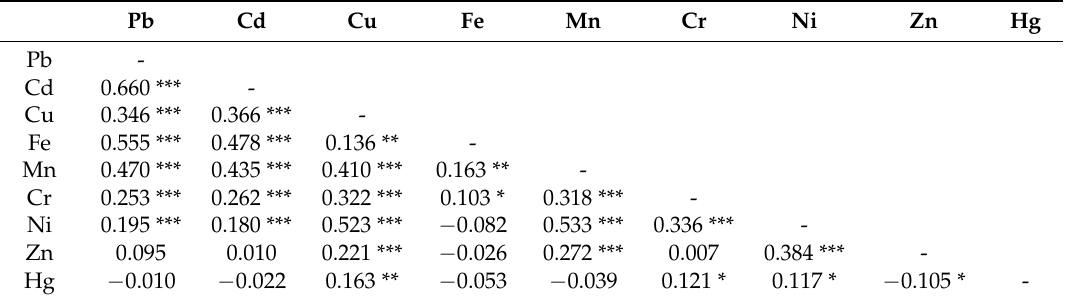
Table 9. Correlation analysis of nine metals in the hair of